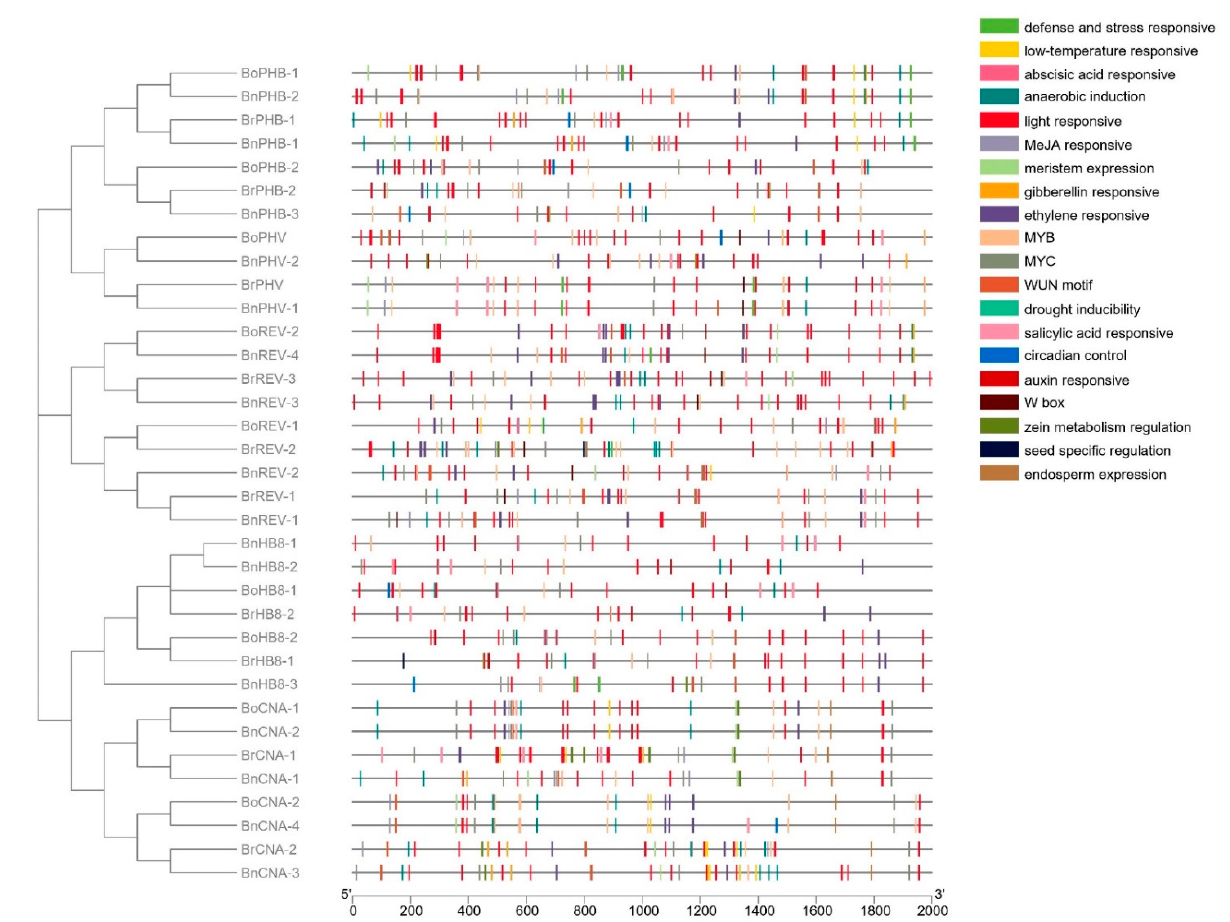
Figure 4. Cis-element analysis of the HD-ZIP III promoters in B. rapa , B. oleracea and B. napus .